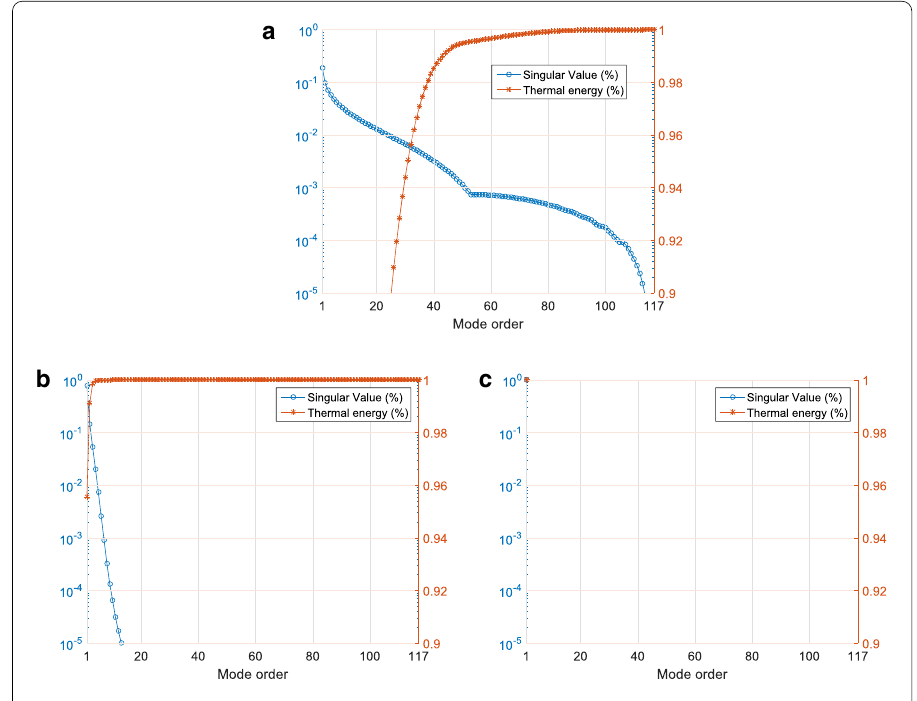
Fig. 8 Modes contribution for θ (top) and ˜ θ (bottom). a Transient state solution in the fixed frame. b Transient state solution in the moving frame. c Steady state solution in the moving frame